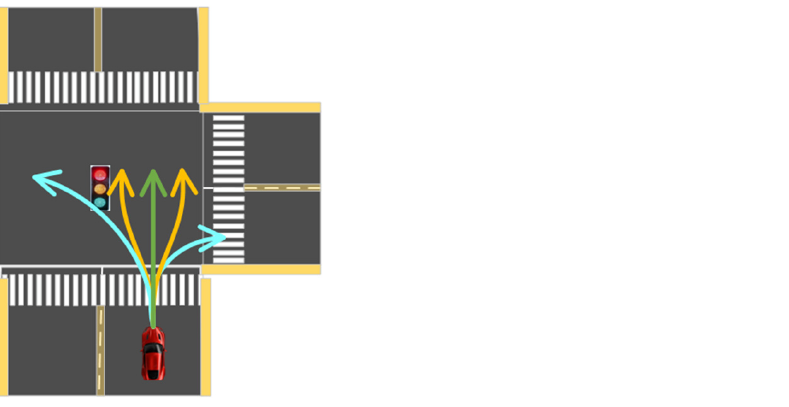
Figure 6. Diagram of ICV action, including straight ahead, left lane change, right lane change, left turn, and right turn.